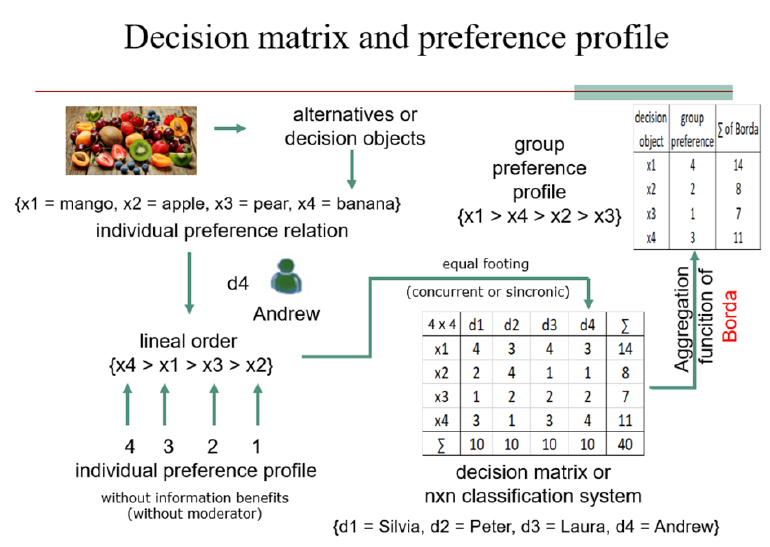
Figure 3. Decision matrix case 4 × 4 with Borda method.